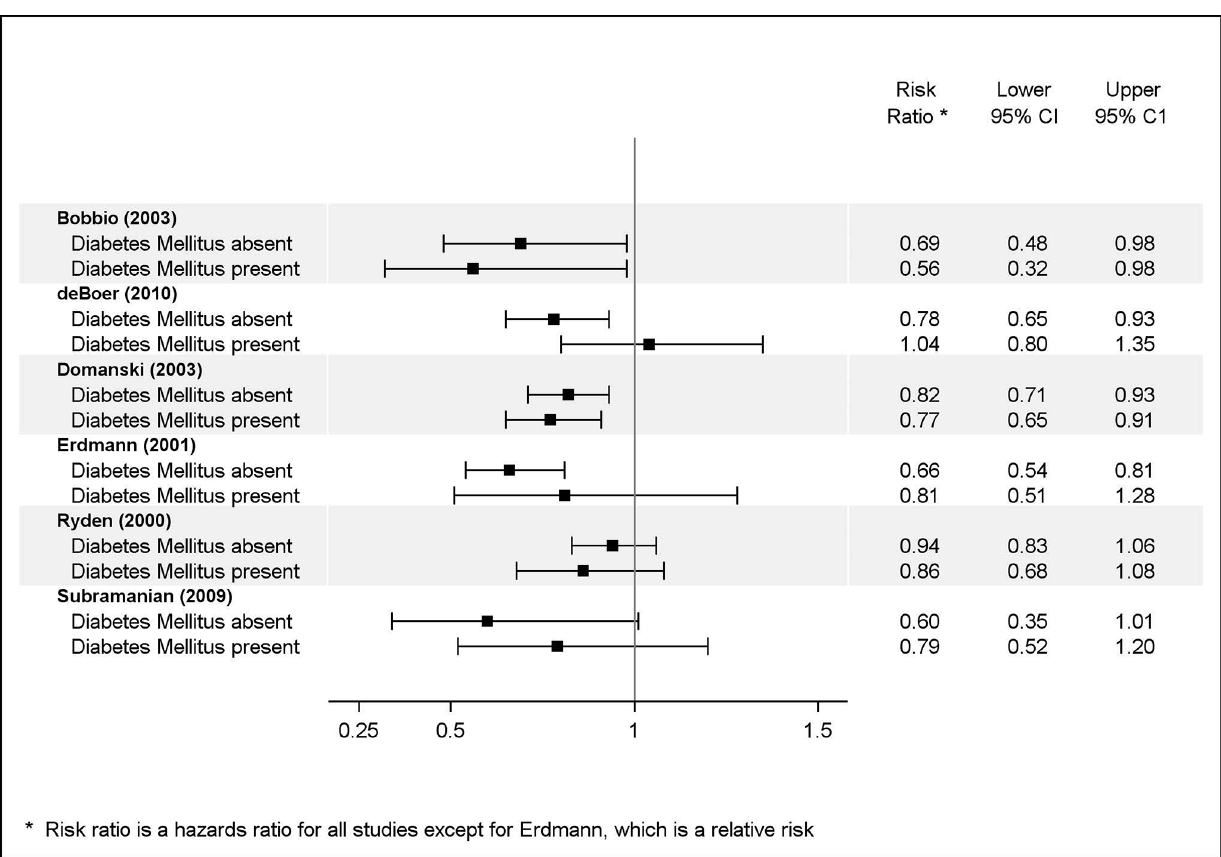
Figure 2. Risk Reduction Associated with Medication for Treatment of Heart Failure.